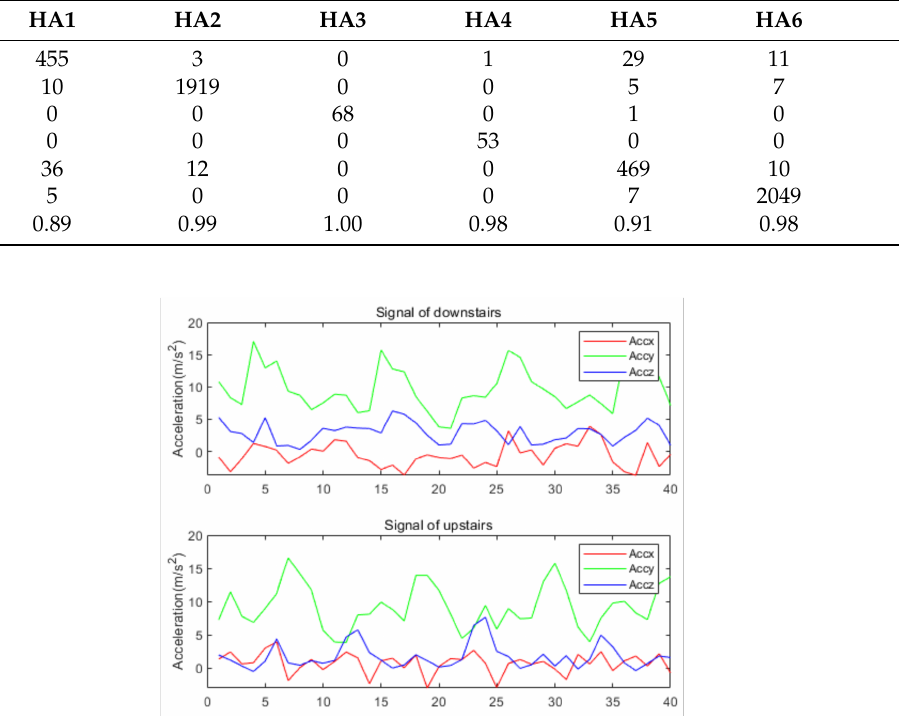
Figure 16. Comparison of the signal of upstairs and downstairs.